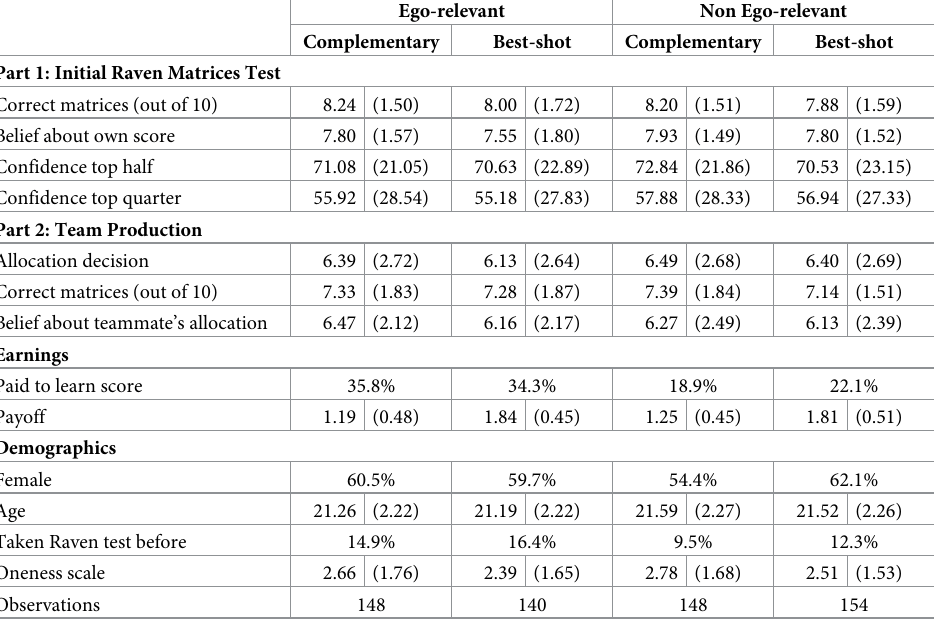
Table 3. Descriptive statistics by treatment.